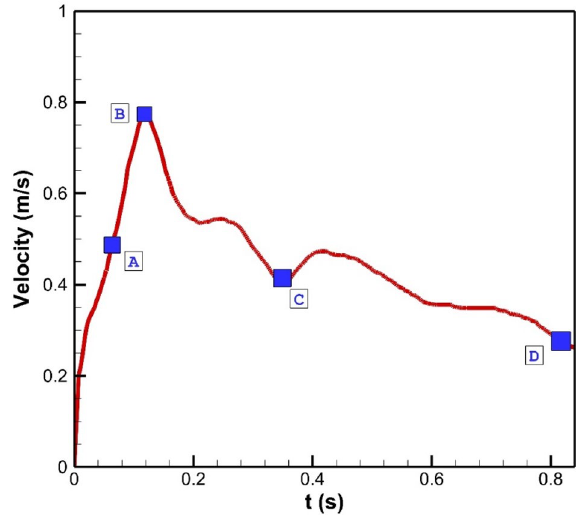
Figure 2. Inflow blood velocity profile 11 .